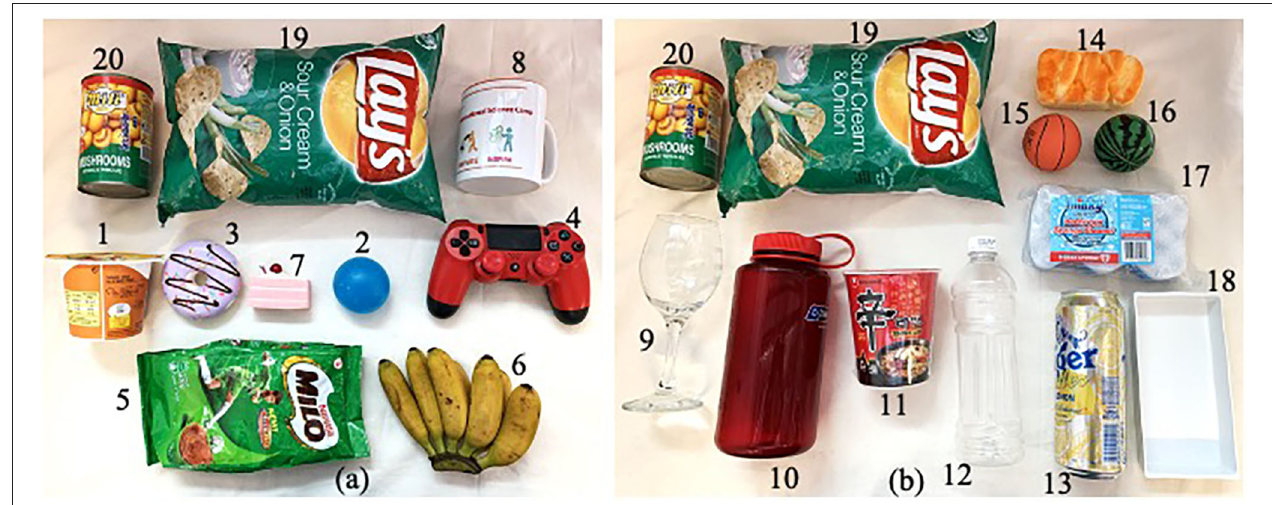
FIGURE 5 | Twenty objects that were used as grasping objects. (a) First set of 8 objects with 2 reference objects, (b) Second set of 10 objects with 2 reference